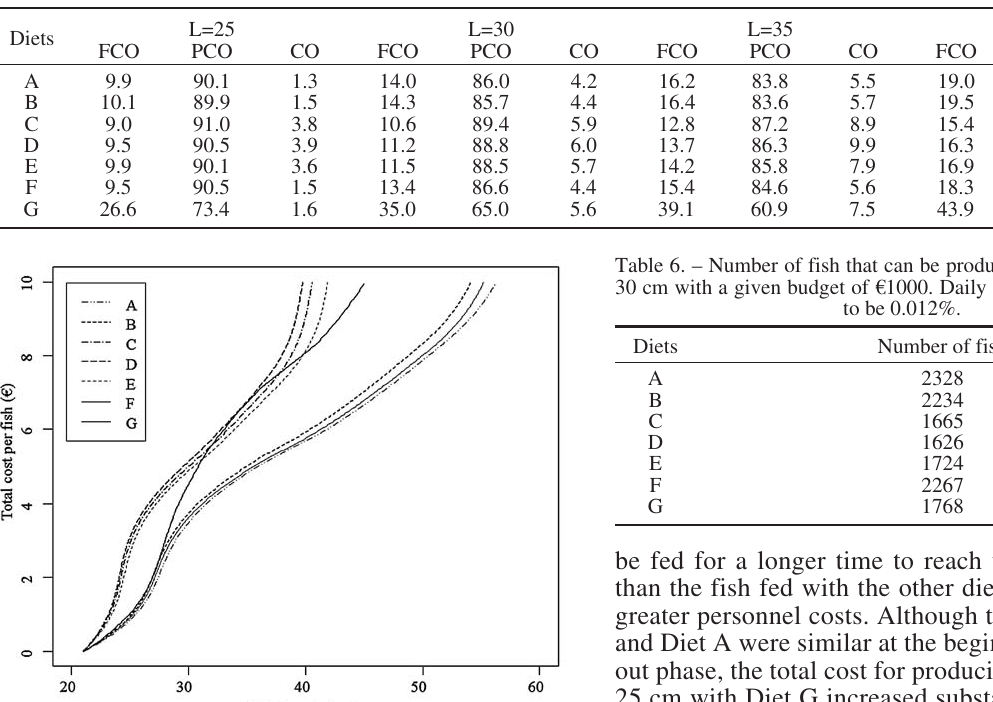
Fig. 3. – Boxplots of the A) crude fat content and B) crude protein content for fish reared on the tested diets. A line within the box marks the median values, and the boundary of the box indicates the 25% and 75% percentiles. The results of the pairwise comparisons, using a Tukey test, are represented by different letters. Table 5. – The total (CO, in € fish –1 ), feeding (FCO, in %) and personnel costs (PCO, in %) for each diet relative to some possible size at release (L, in cm).